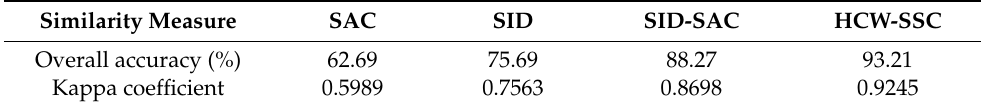
Table 4. Overall accuracy and kappa coefficient of each similarity measure based on OMIS HSI (spectral angle cosine (SAC), spectral information divergence (SID), spectral information divergence– spectral angle cosine (SID-SAC), and a new hybrid changing-weight classification method with a filter feature selection